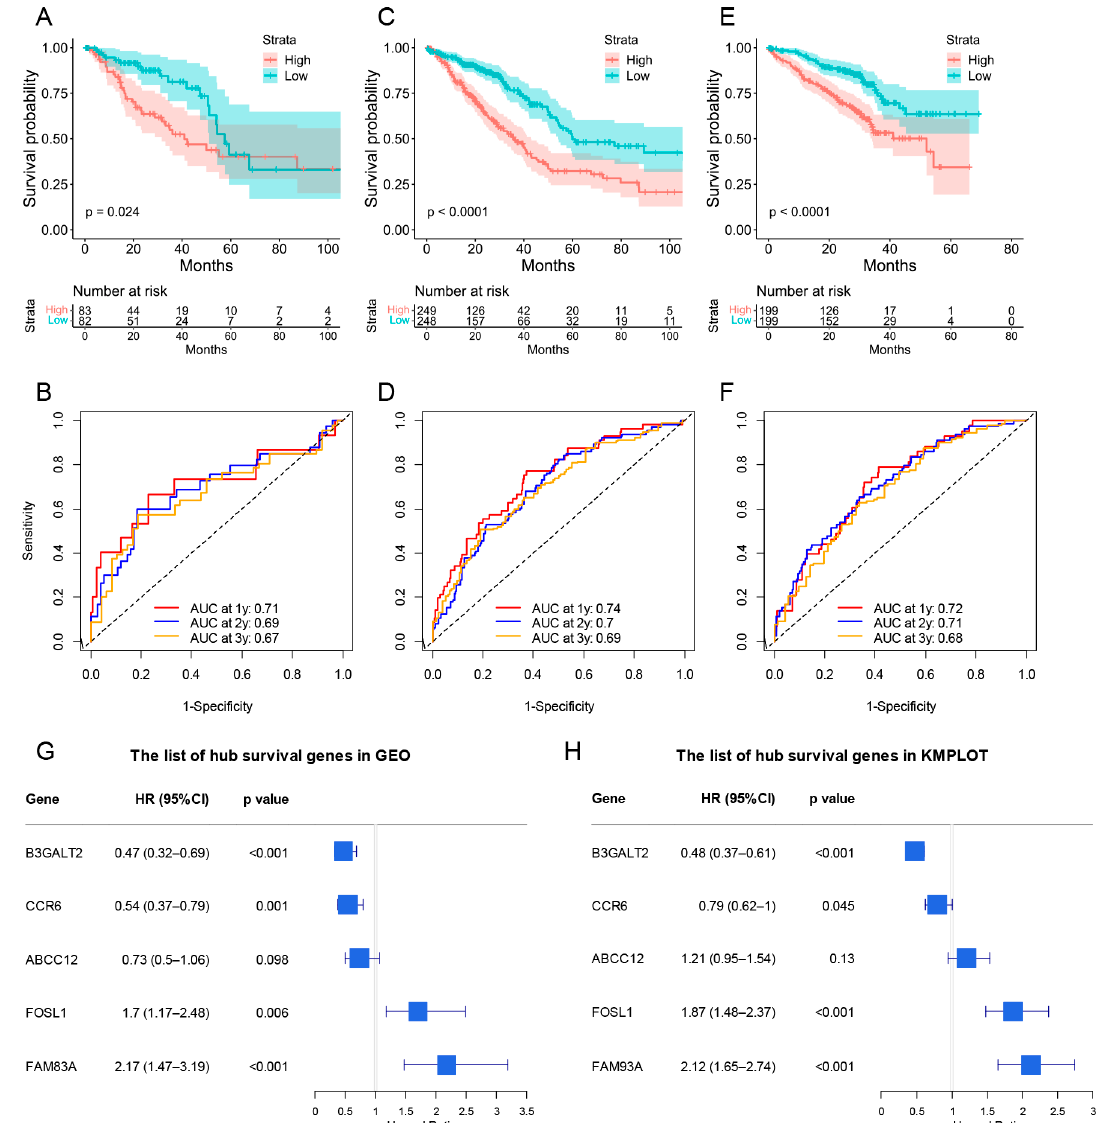
Figure 10. The validation of risk score model for predicting OS of LUAD. ( A – F ) The validations of KM plot and AUC plot were constructed from the TCGA-LUAD validation group ( A , B ), total TCGA-LUAD group ( C , D ), and GEO-LUAD group ( E , F ). ( G , H ) The forest plot containing the hub genes in GEO database and KMPLOT database (B3GALT2, CCR6, ABCC12, FOSL1, and